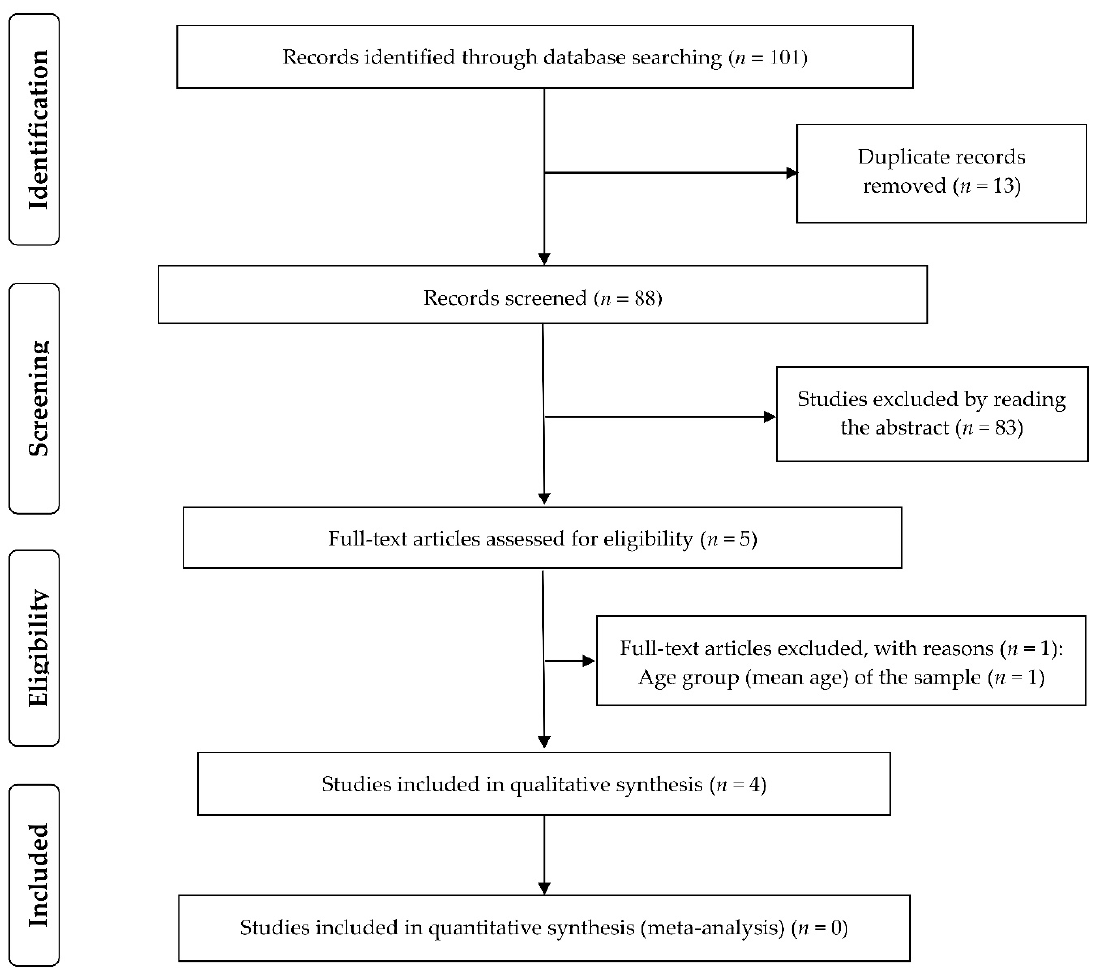
Figure 1. The preferred reporting items for systematic reviews and meta-analyses (PRISMA) flow chart for selection of studies.